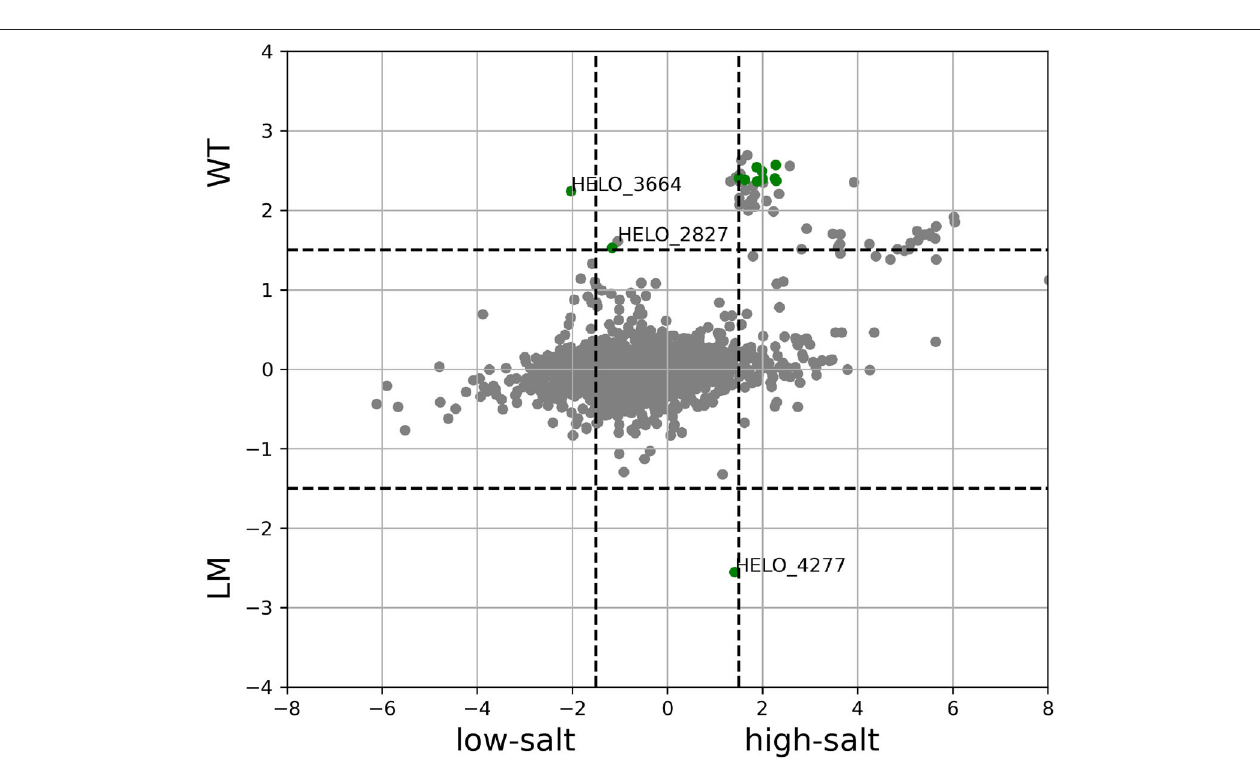
FIGURE 12 | Difference in transcription levels between low and high salt ( x -axis) and between strain KB2.13 and wild type ( y -axis) both in log2-fold-change. Genes in green are those marked as differentially expressed according to both DESeq and TPM